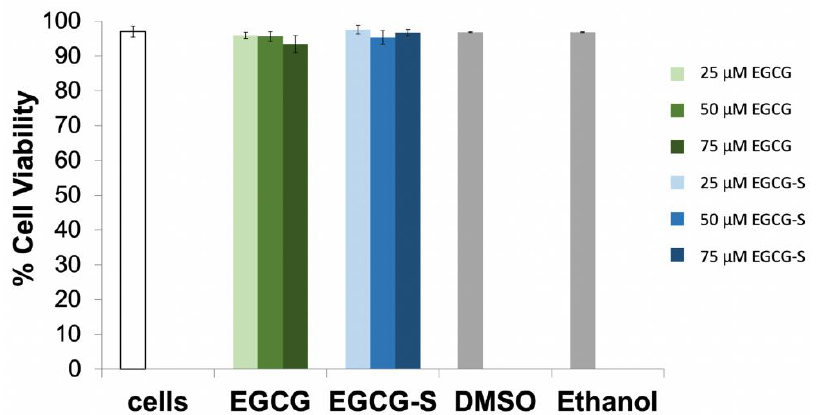
Figure 1. Cell viability assay with EGCG and EGCG-S. Vero cells were cultured in 6-well plates and treated with 25, 50, and 75 µM concentrations of EGCG and EGCG-S, respectively for one hour. DMSO and ethanol were used to determine their effect on Vero cells. The percentage of Vero cell viability was determined by using Trypan blue.